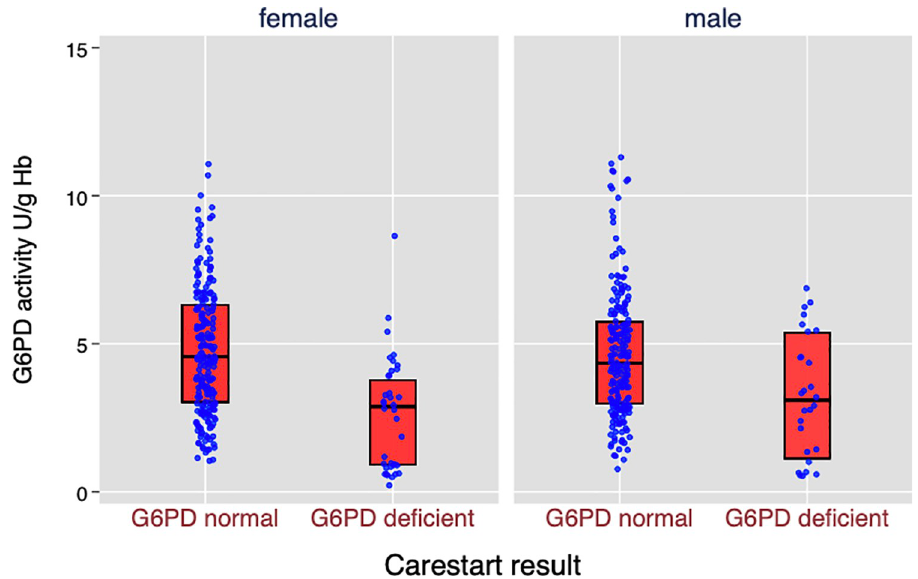
Fig 4. Distribution of G6PD activities, by CareStart results (n = 490).